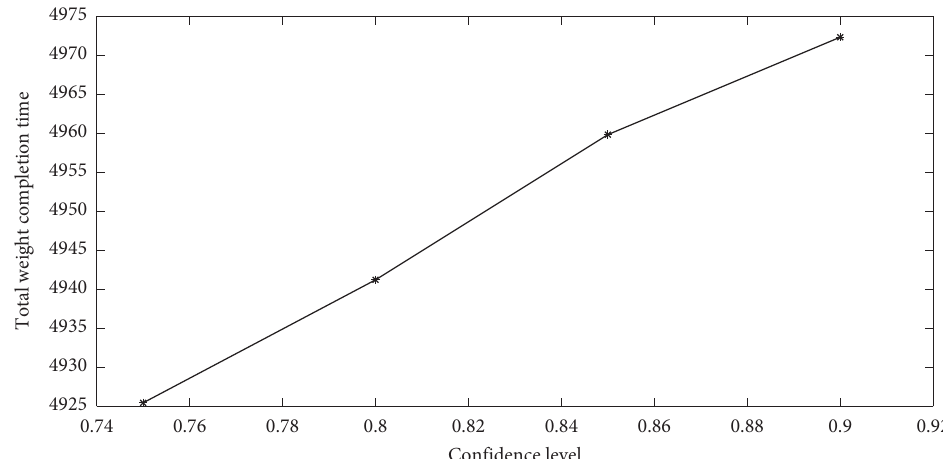
Figure 3: The sensitivity of solution for total weight completion time